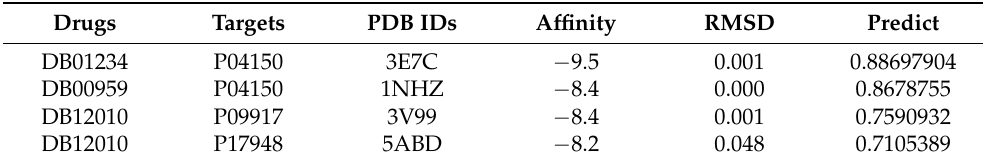
Figure 11. 3D structural visualization of docking results. ( a ) DB01234_3E7C. ( b ) DB00959_1NHZ. ( c ) DB12010_3V99. ( d ) DB12010_5ABD. Table 4. Docking results of top four drug–target pairs